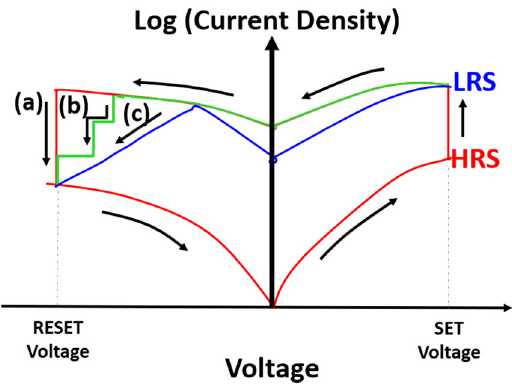
Figure 3: Typical resistive switching pro fi le of bio - organic - based RRAMs recorded by current – voltage ( I – V ) measurement and trans - formed to the semi - log plot of current density – voltage pro fi les with an abrupt increment of current density at a set voltage. Three di ff erent switching pro fi les for the transition from LRS to HRS: ( a ) single - reset voltage step, ( b ) multireset voltage steps, and ( c ) nondistinct reset voltage. Figure 4: Schematic of a bio